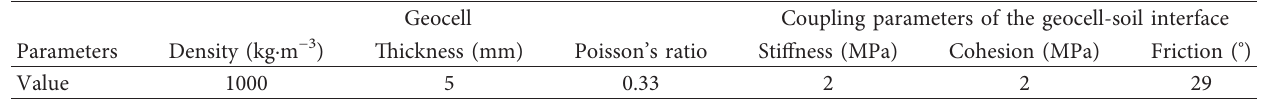
Table 2: Related parameters of the geocell.